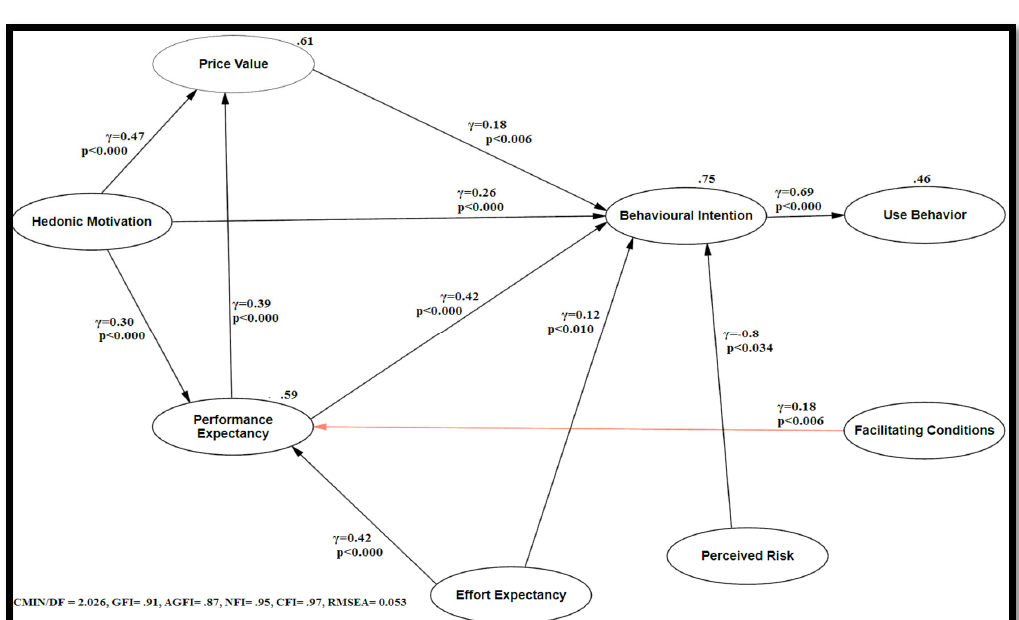
Fig. 4. Telebanking SEM